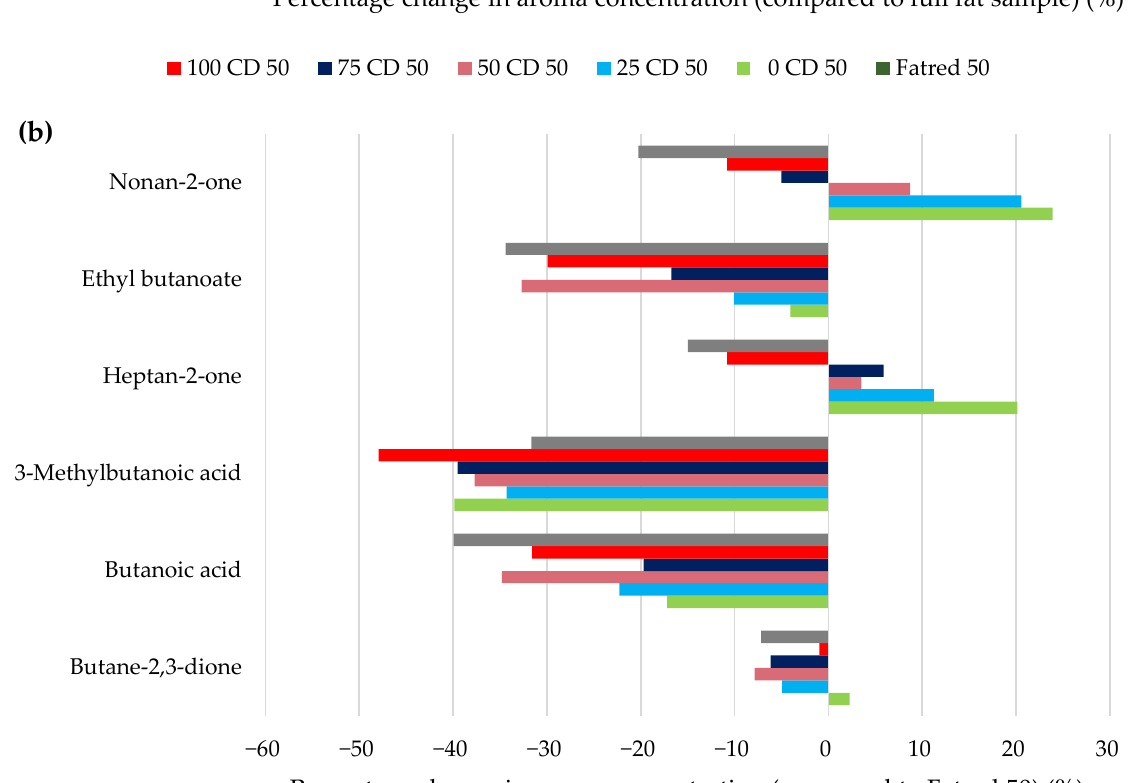
Figure 10. Percentage change in the headspace aroma concentration of the full-fat and 50% reduced- fat samples (Fatred 50 and Y CD 50 samples) compared to the full fat sample ( a ) and the Fatred 50 sample ( b ).